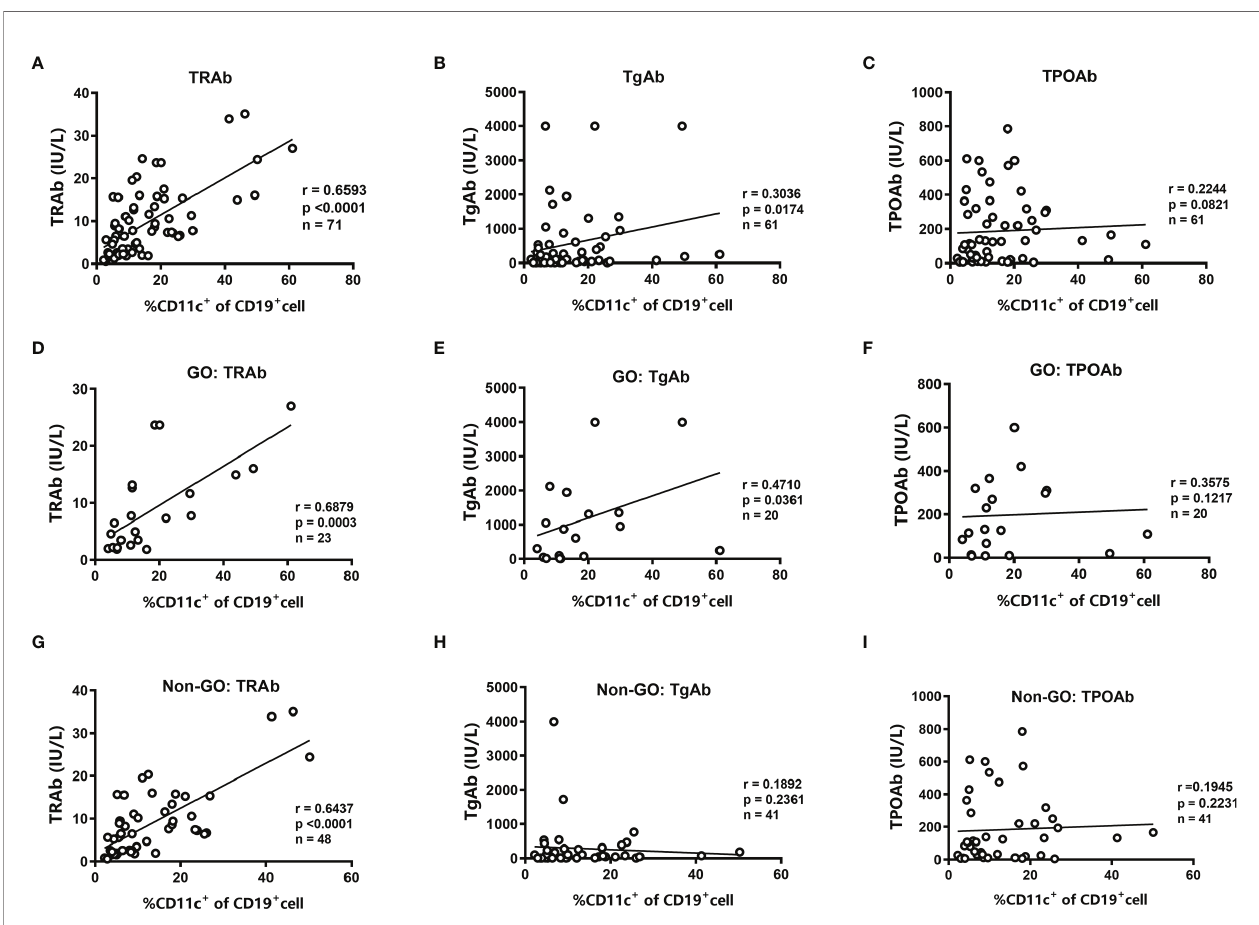
FIGURE 2 | Analysis of the correlations between the frequency of CD11c + B cells and the levels of thyroid autoantibodies. (A – C) Linear correlation analysis between the levels of anti-thyrotropin receptor antibodies (TRAbs), anti-thyroglobulin antibodies (TgAbs), or anti-thyroid peroxidase antibodies (TPOAbs) and the frequency of CD11c + B cells in CD19 + B cells for all enrolled GD patients. (D – F) Linear correlation analysis between the titer of TRAbs, TgAbs, or TPOAbs and the frequency of CD11c + B cells in CD19 + B cells for enrolled GO patients. (G – I) Linear correlation analysis between the titer of TRAbs, TgAbs, or TPOAbs and the frequency of CD11c + B cells in CD19 + B cells for enrolled non-GO patients. The correlation analyses above were performed using the Spearman correlation test. P < 0.05 was considered statistically signi fi